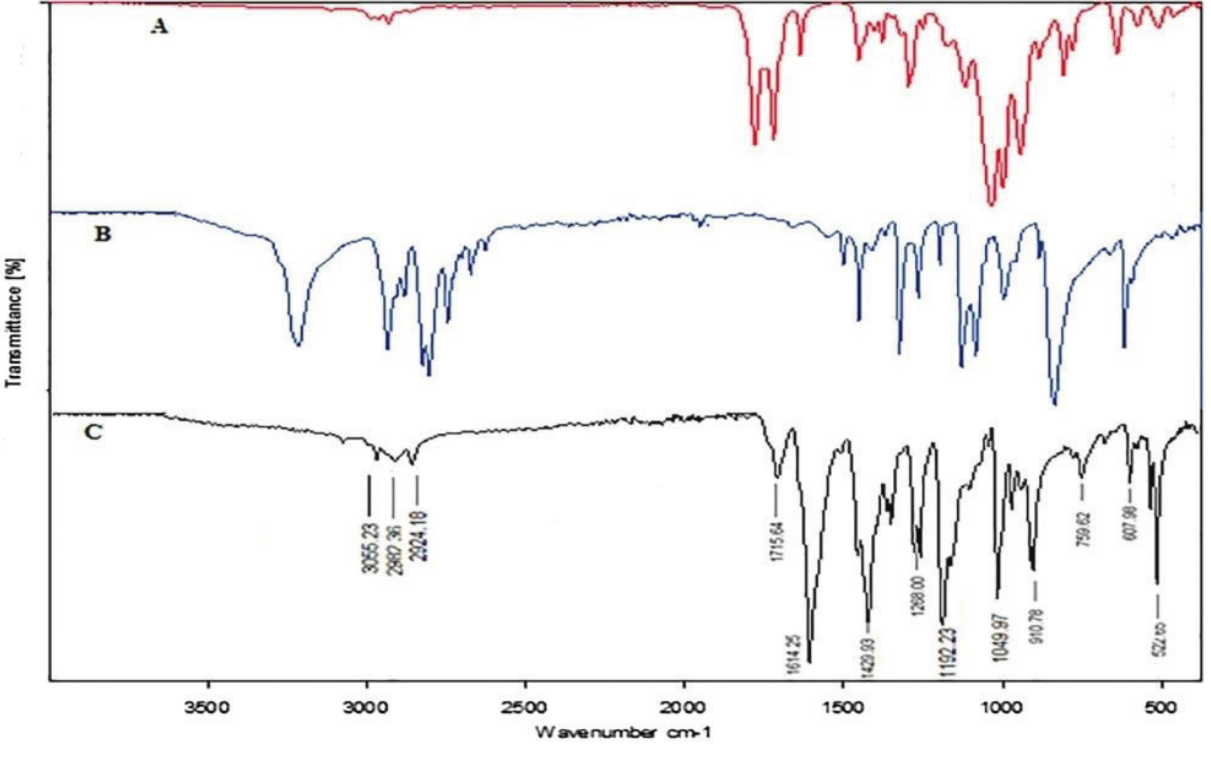
Figure 5: IR spectra of (a) methacrylic anhydride, (b) piperazine and (c) NBMP.